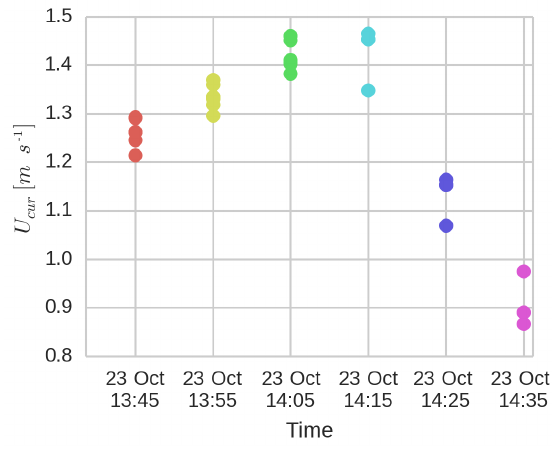
Figure 7. Evolution of the current speed during the drift of the buoys. For each time segment, each dot represents a single